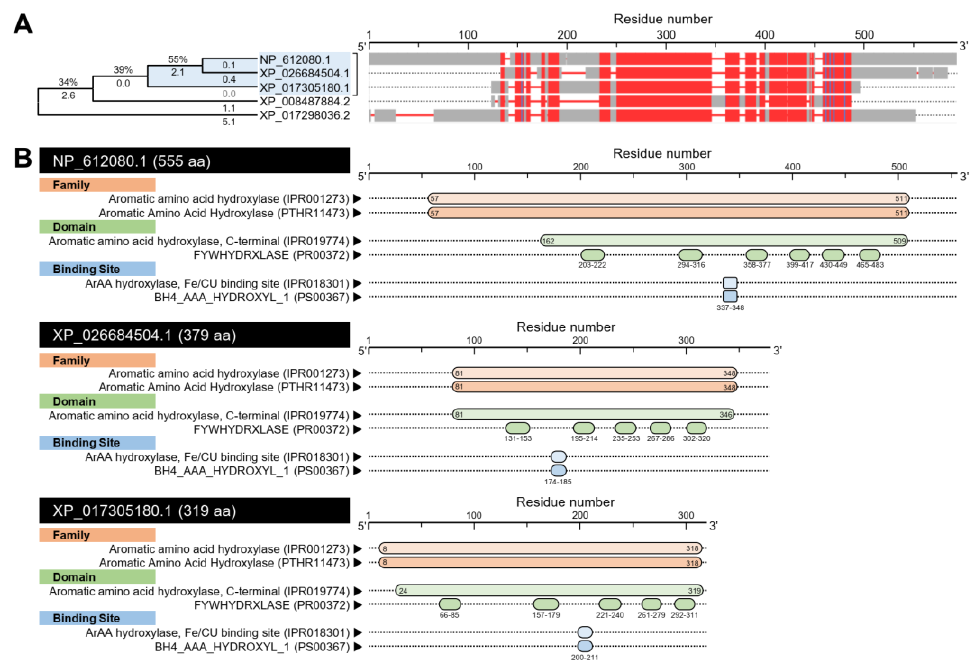
Figure 1. In silico analysis of tryptophan 5-hydroxylase ( DcT5H ) of Diaphorina citri . ( A ) Evolutionary analysis using maximum likelihood method and its associated multiple protein sequences alignments using Constraint-Based Alignment tool (COBALT) analysis. The AA sequences were identified using Protein–Protein BLAST (BLASTp) using tryptophan hydroxylase ( DmT5H ; GenBank Accession no. NP_612080.1) from Drosophila melanogaster , as a query sequence, against Diaphorina citri genome available in GenBank, the national center for biotechnology information website (NCBI, http://www.ncbi.nlm.nih.gov/gene/, 12 February 2021). The tree with the highest log likelihood (−5340.89) is shown. The tree is drawn to scale, with branch lengths measured in the number of substitutions per site (next to the branches). The proportion of sites where at least one unambiguous base is present in at least 1 sequence for each descendent clade is shown next to each internal node in the tree. Evolutionary analyses and the joint tree were conducted in MEGA-X software. In